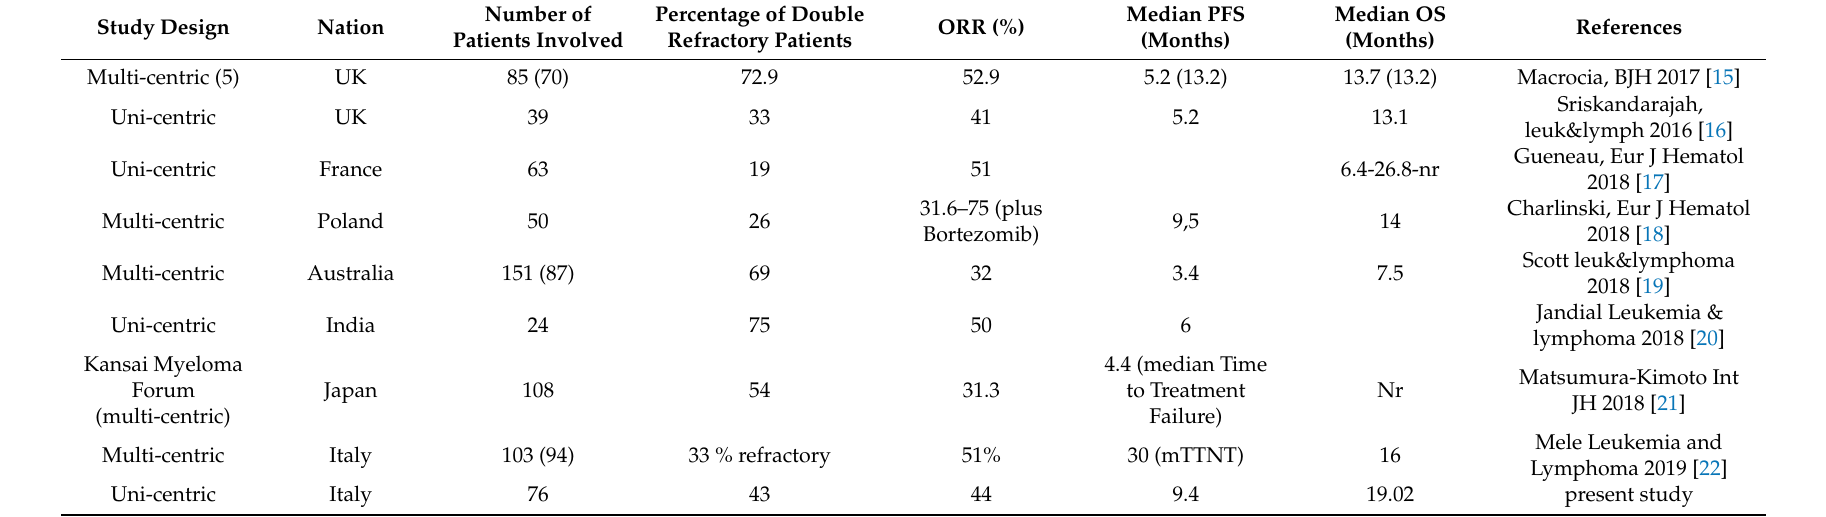
Table 1. E ffi cacy of pomalidomide and dexamethasone (PomaD) in real-world